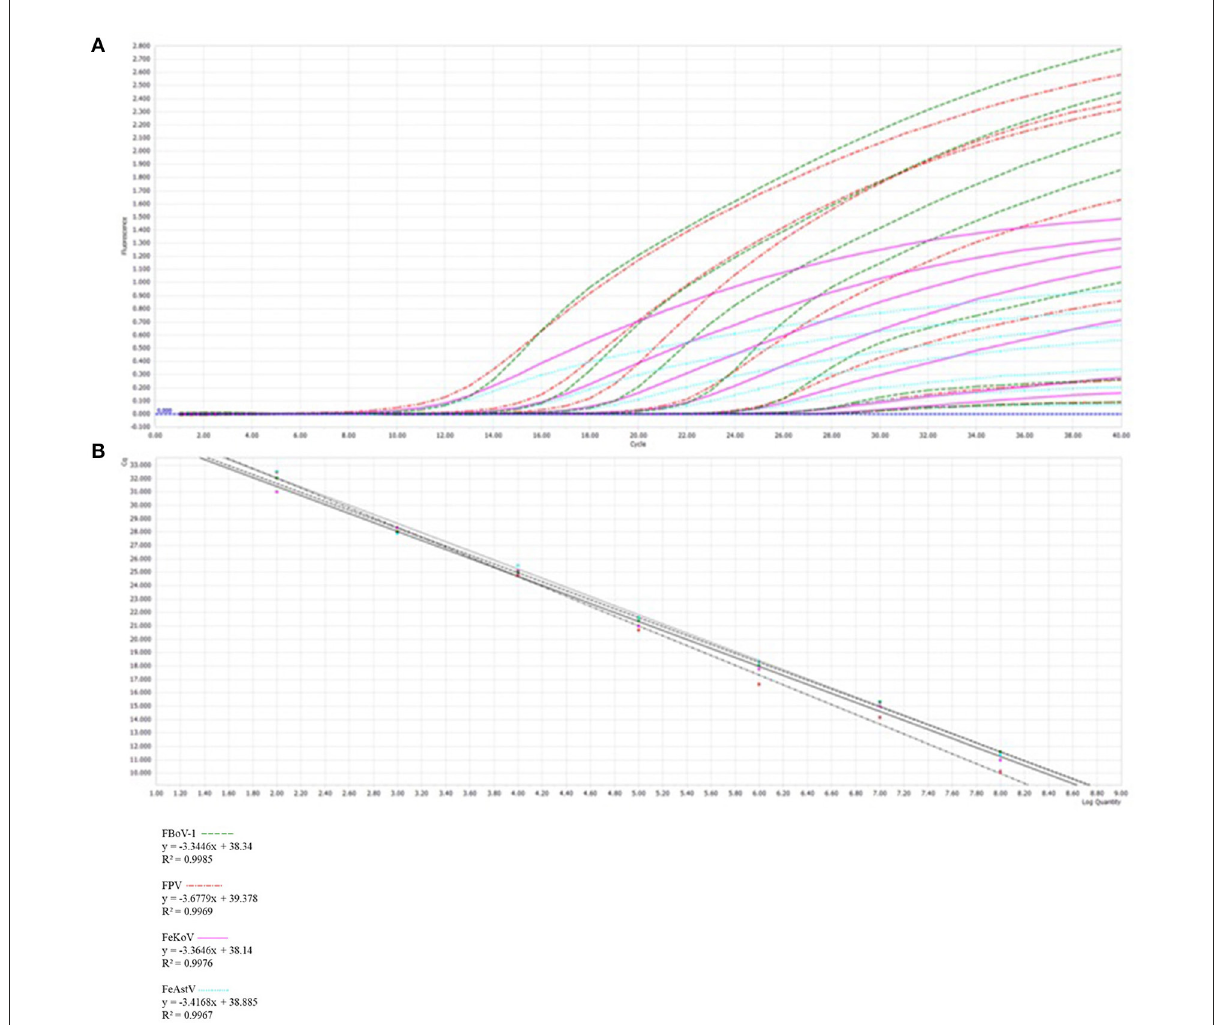
FIGURE2 Development of a multiplex qPCR detection method. (A) The amplification curves (top, X-axis: Cycle, Y-axis: Fluorescence) and standard curve (bottom, X-axis: Log Quantity, Y-axis: Cq) for a multiplex qPCR assay of feline parvovirus (FPV), feline bocavirus 1 (FBoV-1), feline kobuvirus (FeKoV) and feline astrovirus (FeAstV). Each virus plasmid is from 10 8 to 10 2 copies/ µ L. (B) Standard curve formulae in the multiplex qPCR for FPV, FBoV-1, FeKoV, and